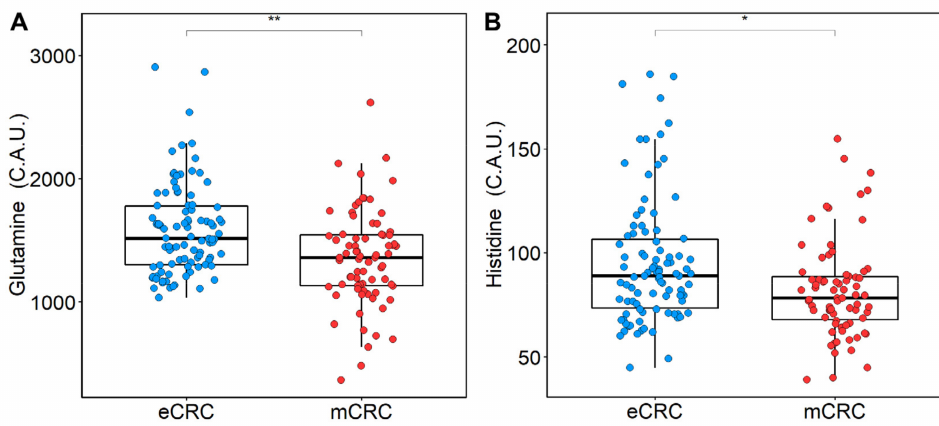
Figure 4. Boxplots of glutamine ( A ) and histidine ( B ) levels in patients with eCRC (blue) and mCRC (red), p -values were obtained using Wilcoxon test and adjusted for FDR. * p < 0.05, ** p <